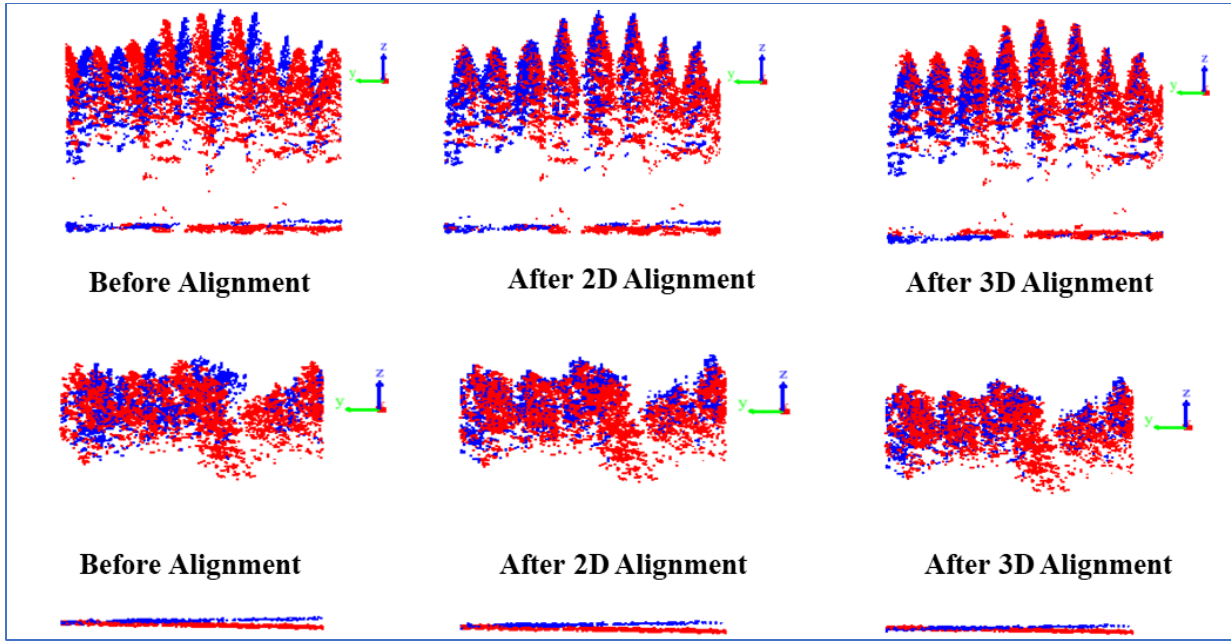
Figure 10. Results of the planimetric and 3D alignment of the point clouds of two plots (top row: profile from test plot I, bottom row: profile from test plot